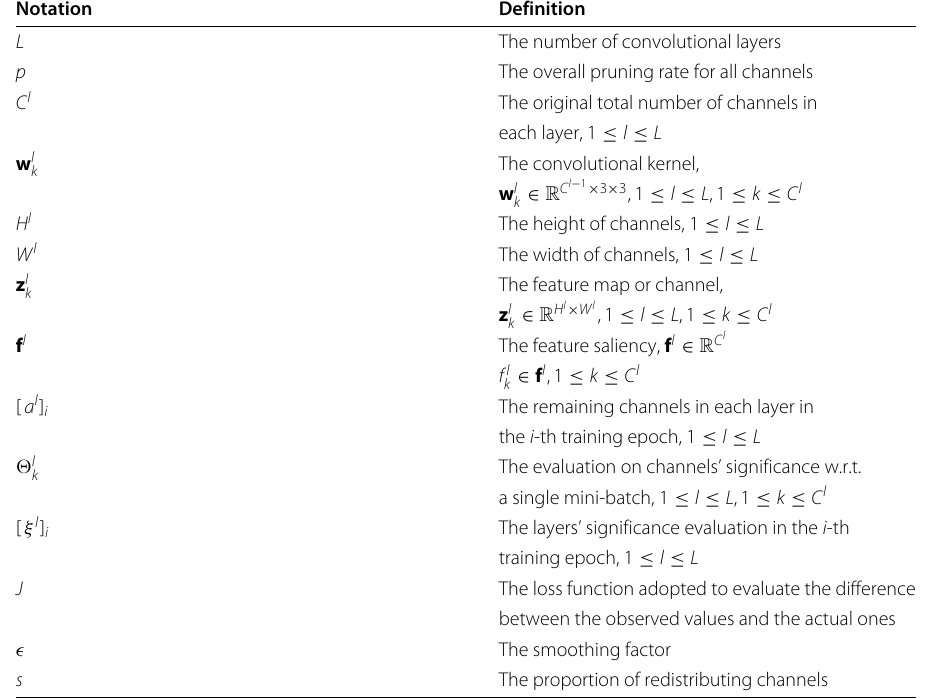
Table 1 Notations and their